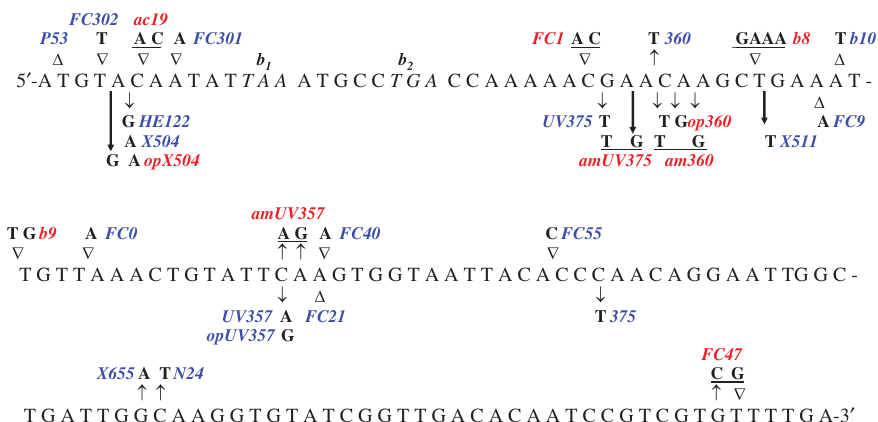
Figure 1 Genetic map of the initial part of rIIB gene of T4 phage; modifi ed from Ref. (46) . The names of the mutations are given in italic type. Mutants with single-base change and those with more than one base change are shown in blue and in red, respectively. ↑ or ↓ means base substitution; ∇ and Δ designate insertion or deletion, respectively, of one or more base pairs. and b designate termination codons (italic) out of phase. New (mutant) nucleotides are in bold; b 1 2